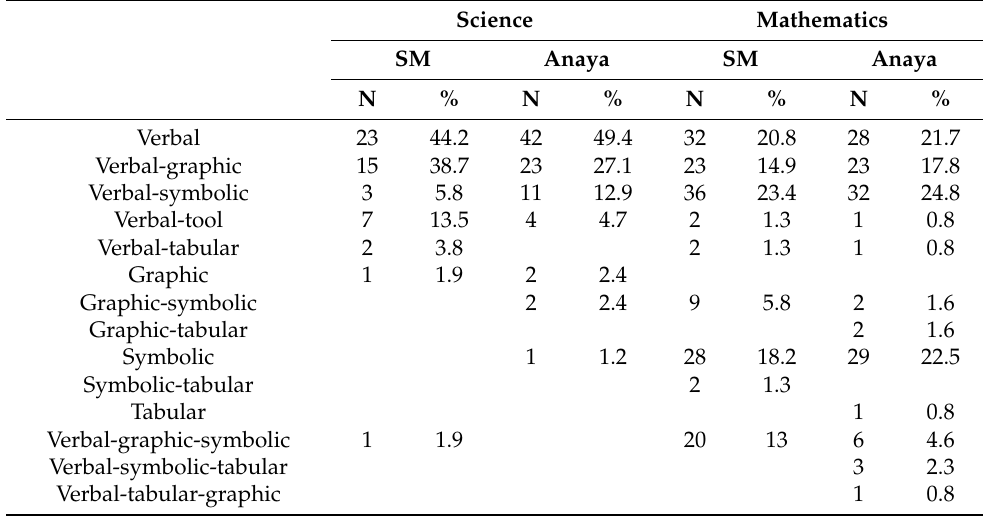
Table 5. Representation systems: frequency of use by subject and publisher.